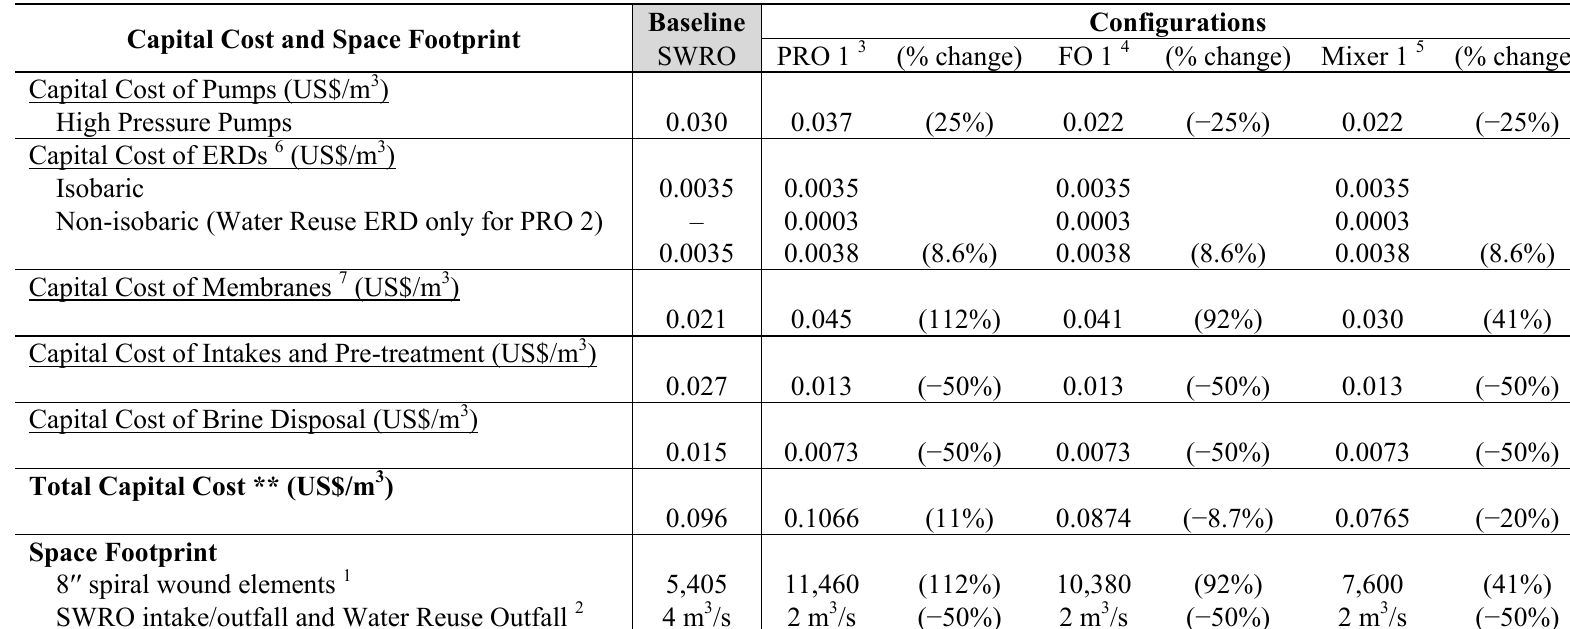
Table A2. Quantitative Comparison of total capital costs and space footprint for the different configurations and the baseline of a conventional SWRO